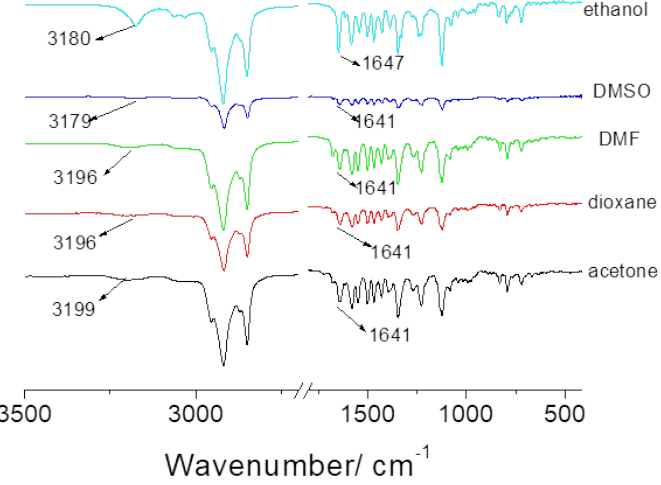
Figure 5. FT-IR spectra of xerogel 1 from different solvents.